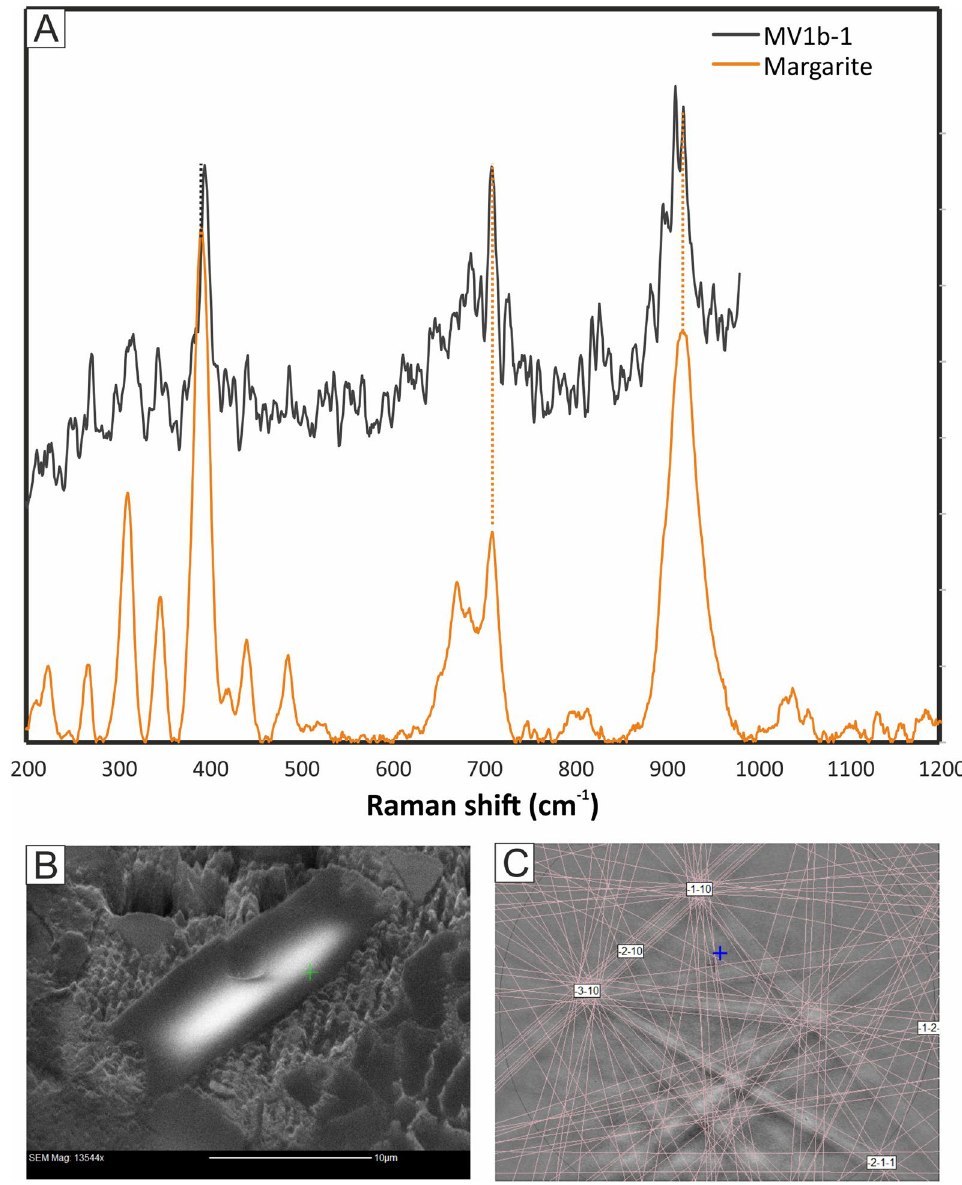
Figure 6. ( A ) Selected Raman spectrum obtained from exogenous margarite in the fracture fill crosscutting MV1b, compared to reference spectrum for margarite (RRUFF R060839). ( B ) Un-coated BSE image of the margarite crystal shown in Fig. 3D, during Electron back-scatter diffraction (EBSD) analysis. ( C ) EBSD pattern indexed with margarite